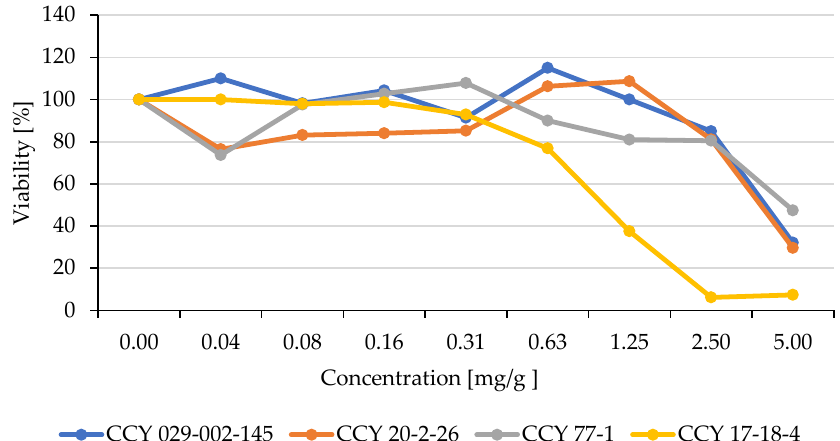
Figure 7. Cytotoxic effect of organic extracts from yeast biomass in the concentration range of 0.04–5 mg/g. From the data obtained from flow cytometry (Figure 8), it is clear that there is a cor- relation between cell cytotoxicity and apoptosis (Figure 9). All of the microbial extracts showed some positive results for apoptosis. From these data, we concluded that the cyto- toxicity of microbial extracts was dose dependent in B16F1 cells. The toxic effects of plant extracts can be correlated to their antioxidant and antimicrobial activity.